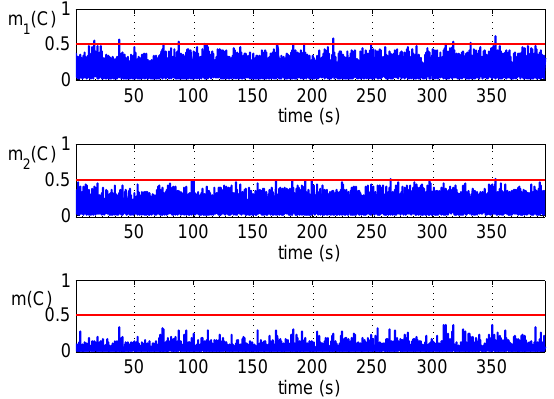
Figure 6. Detections’ fusion of the clean static dataset.